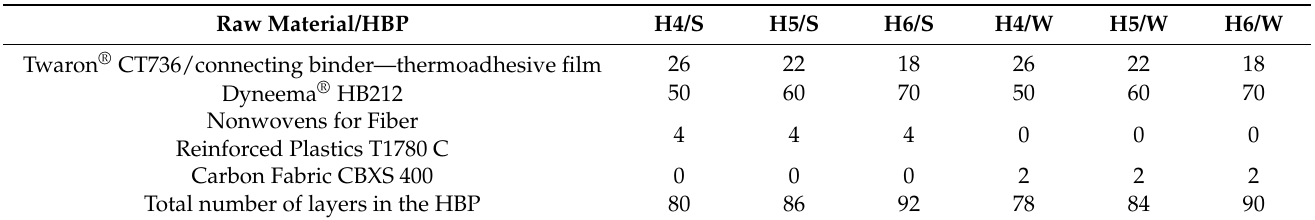
Table 4. HBP (three-components hybrid) materials used in both Variants A and B. Raw